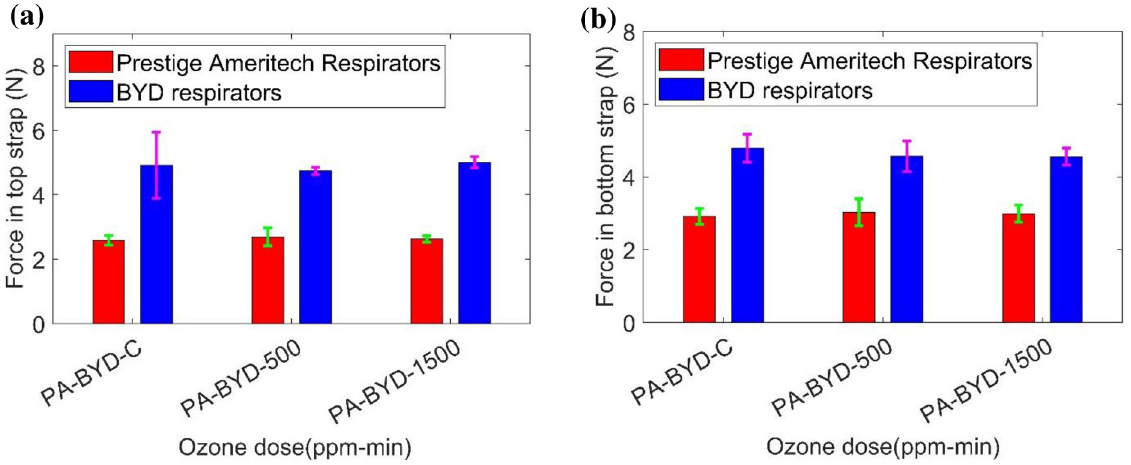
Fig 22. Tensile force in the respirators (Prestige Ameritech and BYD) (a) top strap and (b) bottom